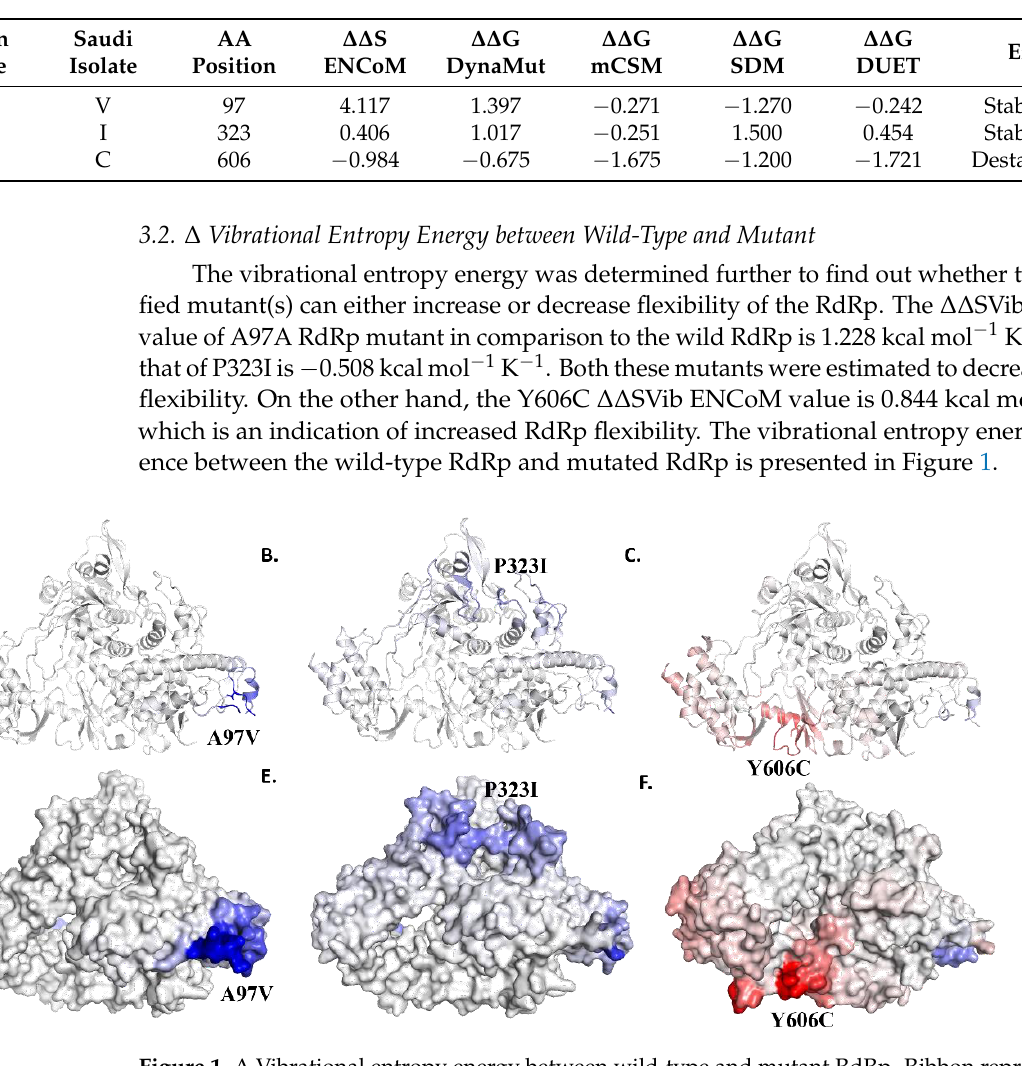
Figure 1. ∆ Vibrational entropy energy between wild-type and mutant RdRp. Ribbon representation showing the change in vibrational entropy energy between wild-type and mutant RdRp due to ( A ) A97V and ( B ) P323I ( C ) Y606C. Surface representation showing the change in vibrational entropy energy between wild-type and mutant PLpro due to ( D ) A97V and ( E ) P323I ( F ) Y606C. Amino acids are colored according to the vibrational entropy change as a consequence of mutation of PLpro protein. Blue represents a rigidification of the structure and red represents a gain in flexibility.